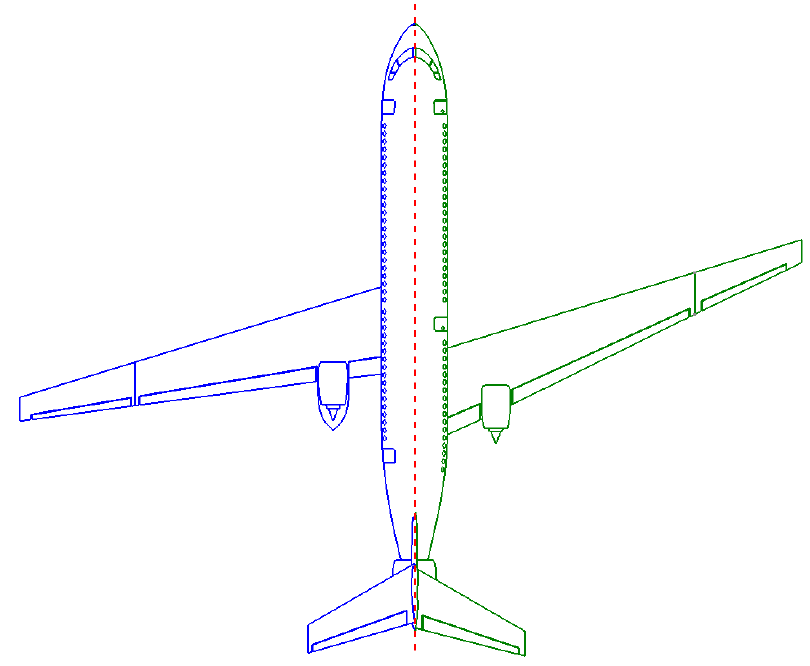
Figure 1. Configuration layouts for the midrange aircraft